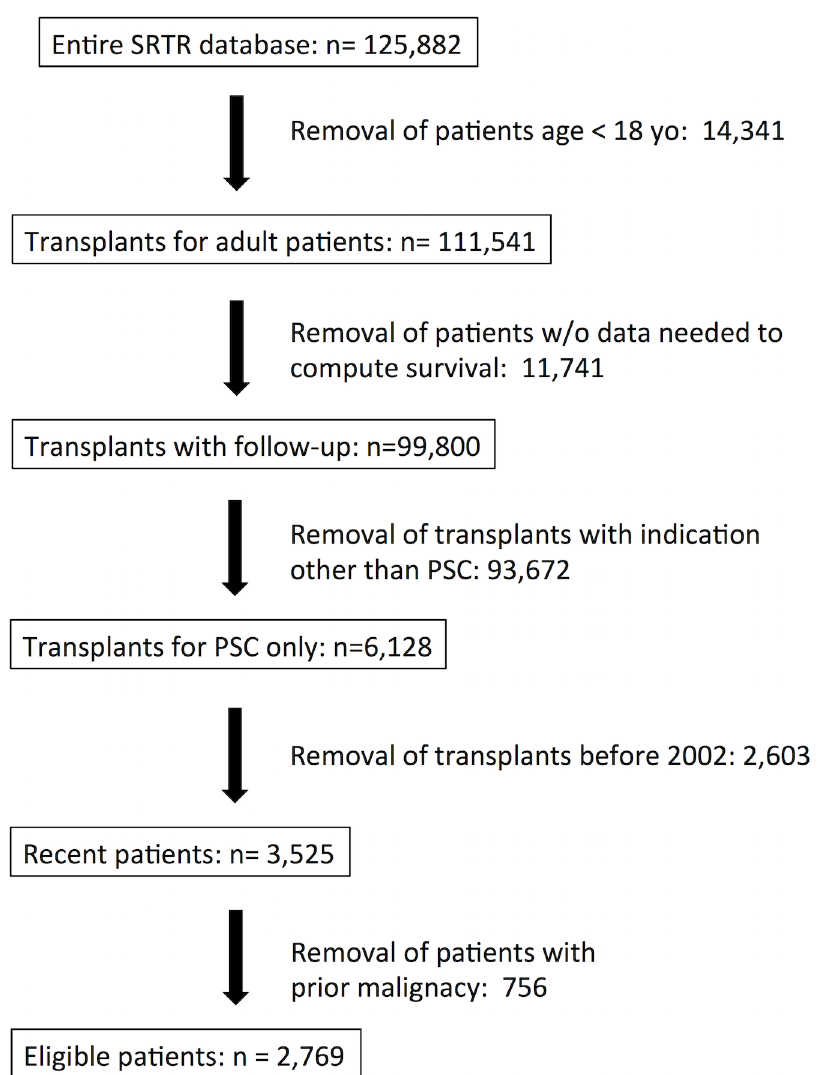
Fig 2. Patients’ selection process. Flow-chart describing the number of excluded (and remaining) patients at each stage of the selection process.